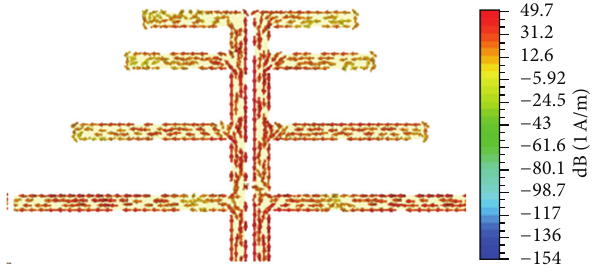
Figure 3: Simulated current distribution of the CPW PLPDA antenna at 35